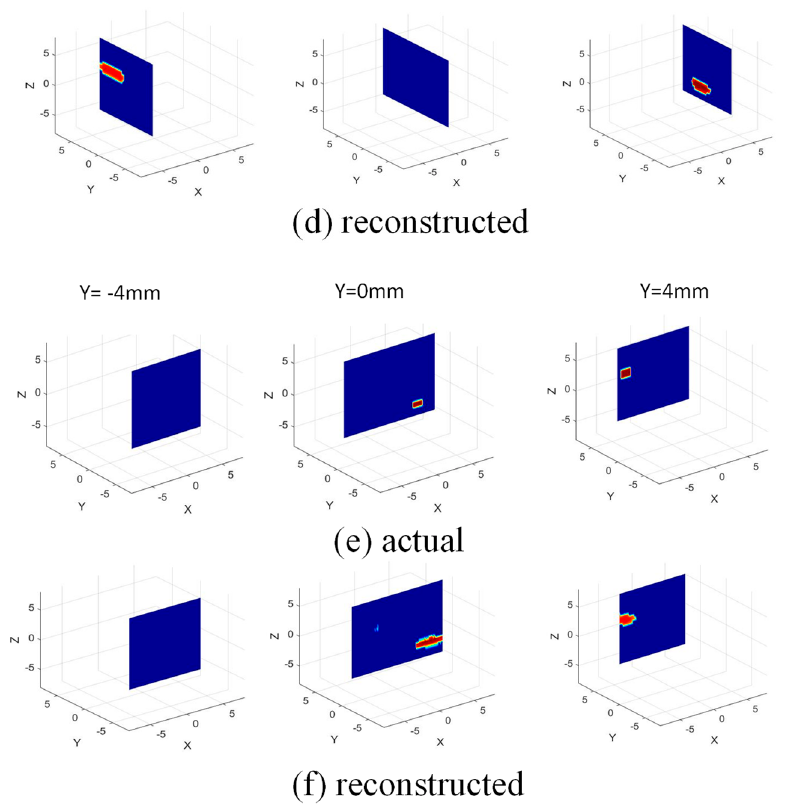
Figure 7. 3D image on different 2D planes: ( a , b ) actual and reconstructed image on xy planes (z = − 4, 0, 4 mm); ( c , d ) actual and reconstructed images on yz planes (x = − 4, 0, 4 mm); ( e , f ) actual and reconstructed images on zx planes (y = − 4, 0, 4 mm), respectively.